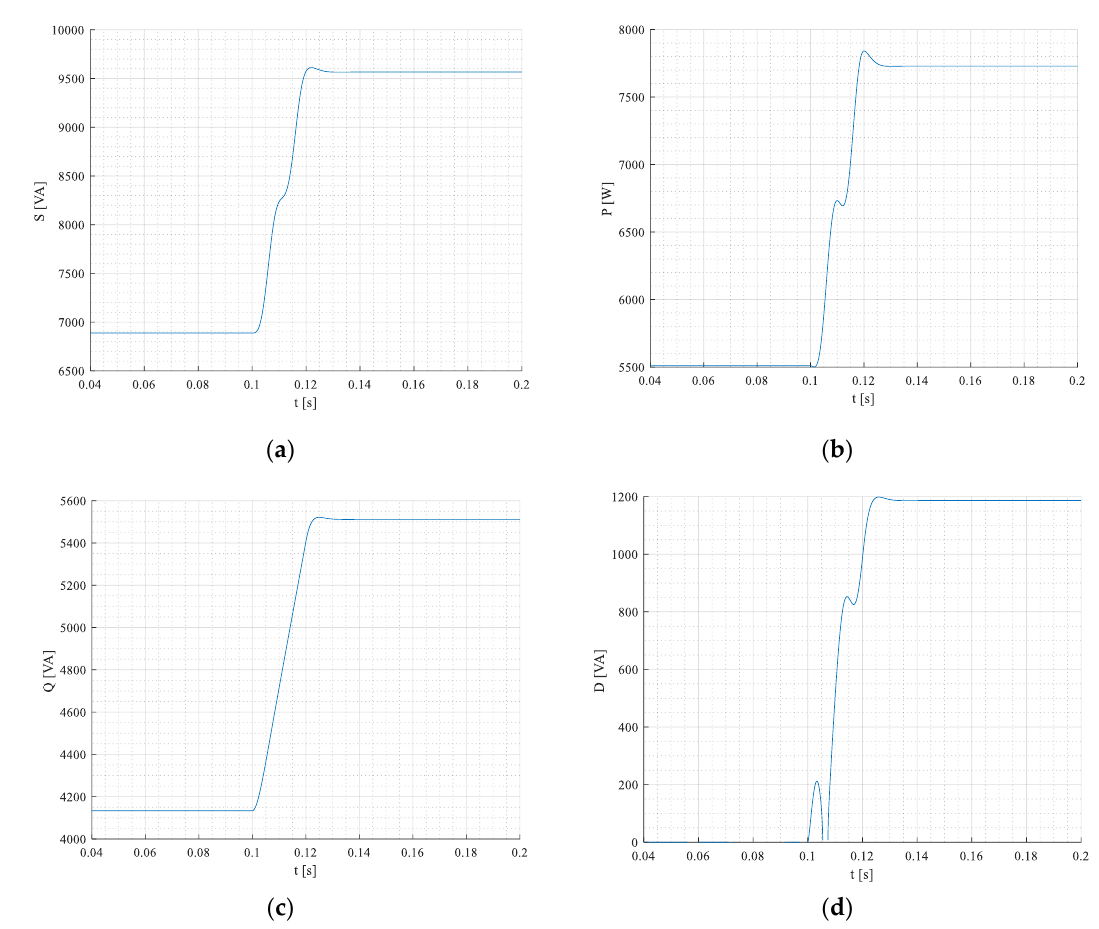
Figure 29. Apparent- ( a ), active-( b ), blind-( c ), and distortion ( d )power components during transient states for the 3-phase system under inverter-supplied non-symmetrical linear RL load. Zero power component 𝑃𝑜 is not equal to zero, and it is shown in Figure 30.